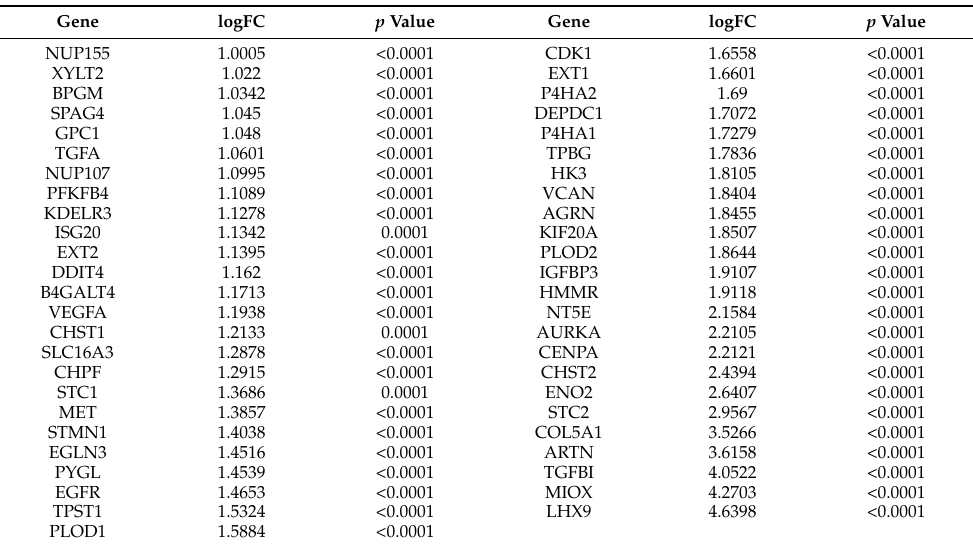
Table 3. The upregulated glycolysis-related genes in